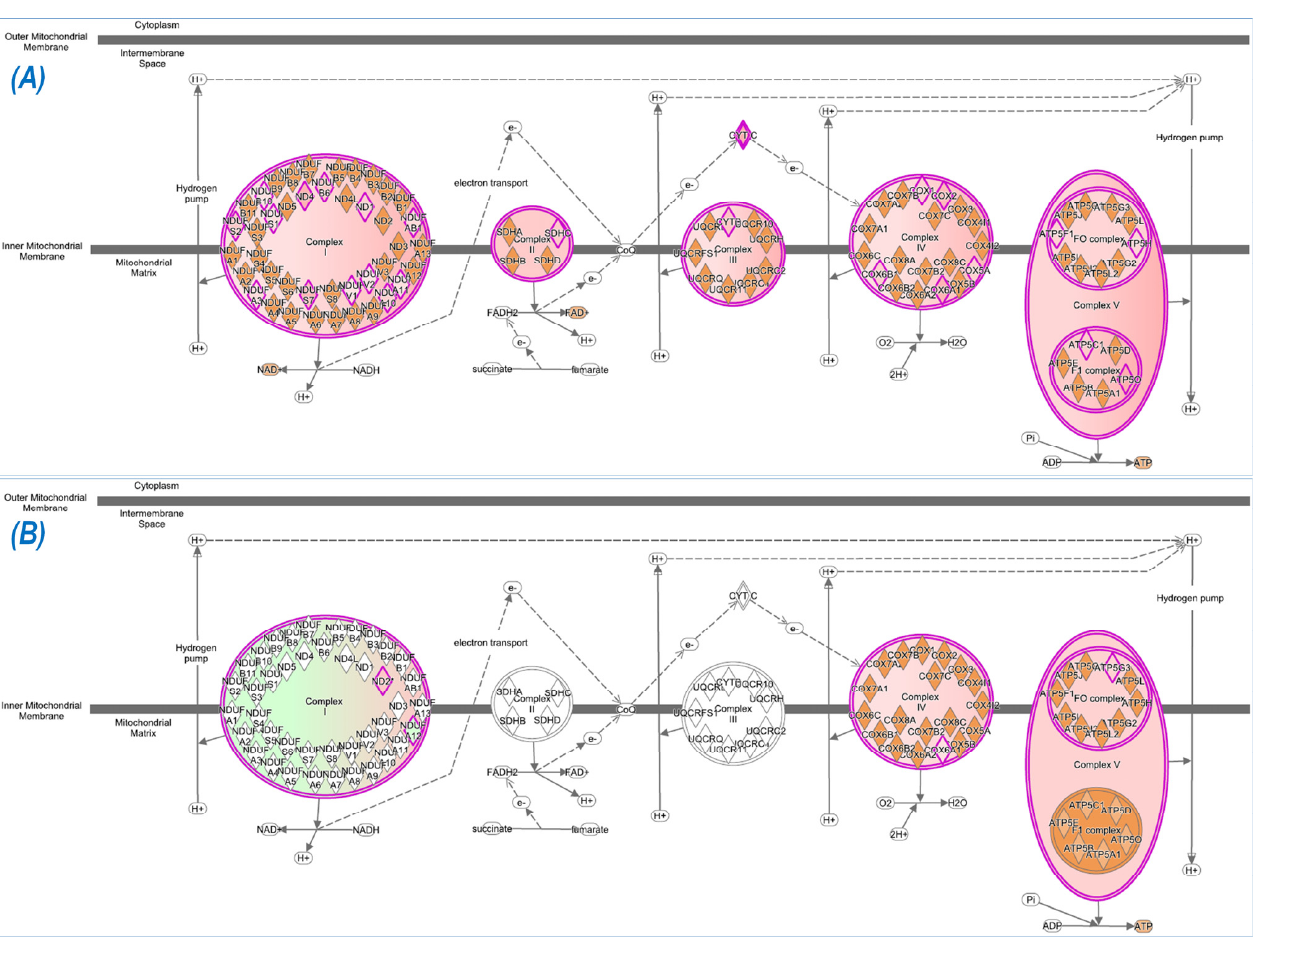
Figure 7. Mitochondrial function and oxidative phosphorylation in WT ( A ) and Nrf2 KO ( B ) mice following ExT. The purple outlined mitochondrial complexes with orange or green tinting are predicated to be functionally enhanced or inhibited, respectively.